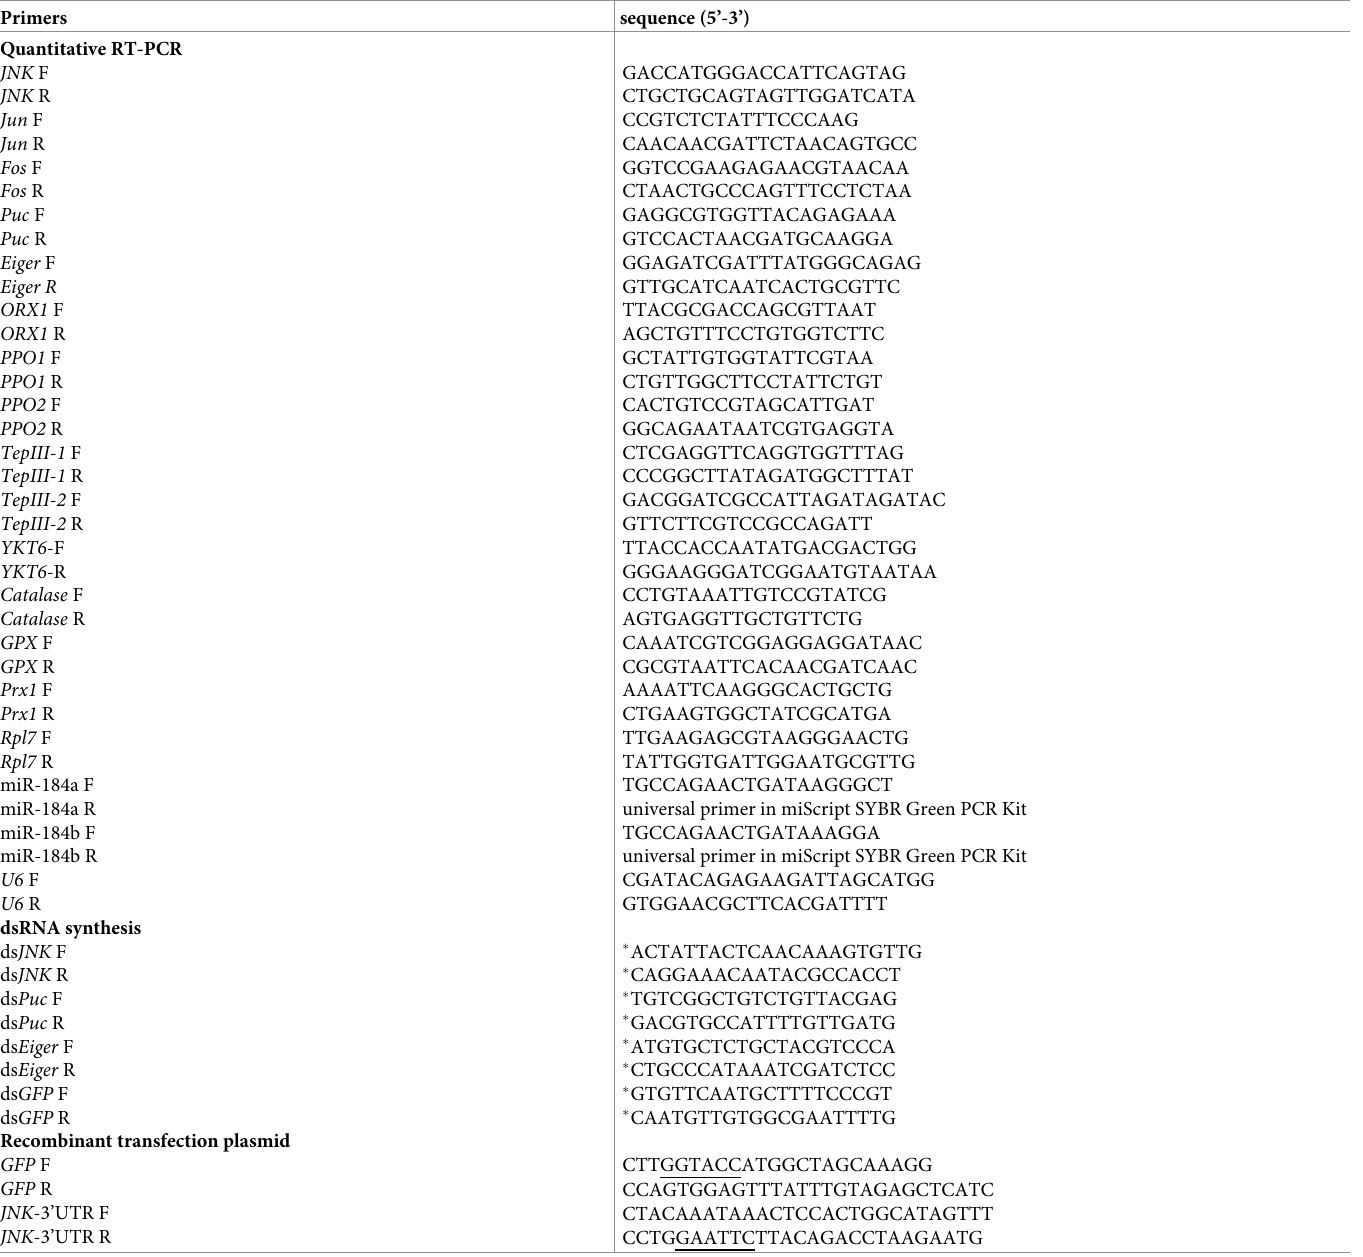
Table 1. Primers used in the